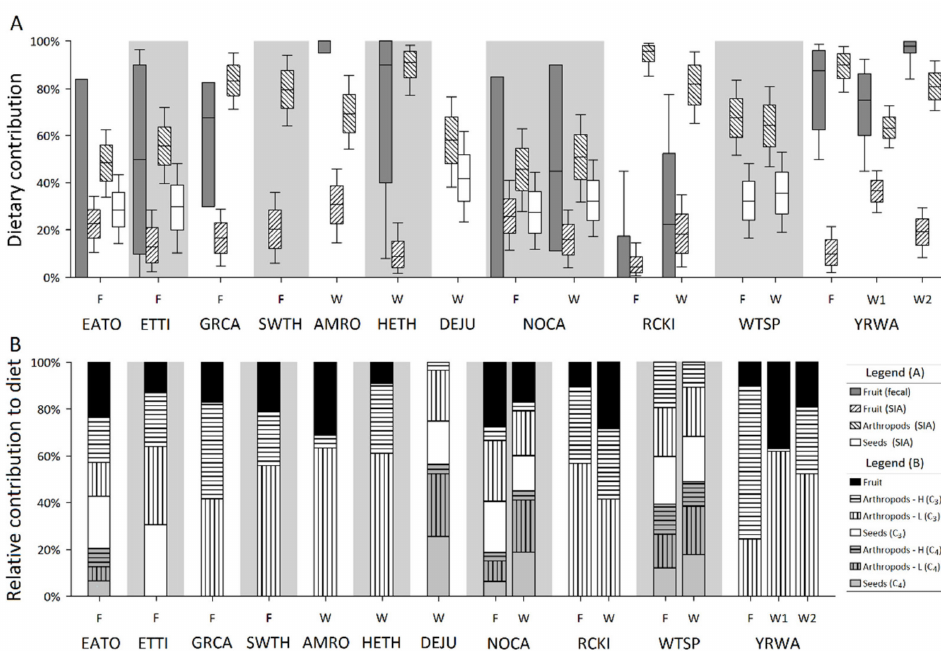
Figure 3. ( A ) Estimated percent of fruit in feces and estimated contribution of fruit, arthropods, and seeds to tissues of individual bird species by stable isotope mixing models during the fall (F) and winter (W; W1 and W2 refer to winter 1998/1999 and winter 1999/2000, respectively). ( B ) A refined breakdown of median resource contributions to tissues of focal songbird species in different seasons as estimated from stable isotope mixing models. This panel includes different patterns to distinguish between C 3 and C 4 sources and between high- and low-trophic arthropods. Species codes: AMRO = American Robin; DEJU = Dark-Eyed Junco; EATO = Eastern Towhee; ETTI = Tufted Titmouse; GRCA = Gray Catbird; HETH = Hermit Thrush; NOCA = Northern Cardinal; RCKI = Ruby-Crowned Kinglet; SWTH = Swainson’s Thrush; WTSP = White-Throated Sparrow; and YRWA = Yellow-Rumped